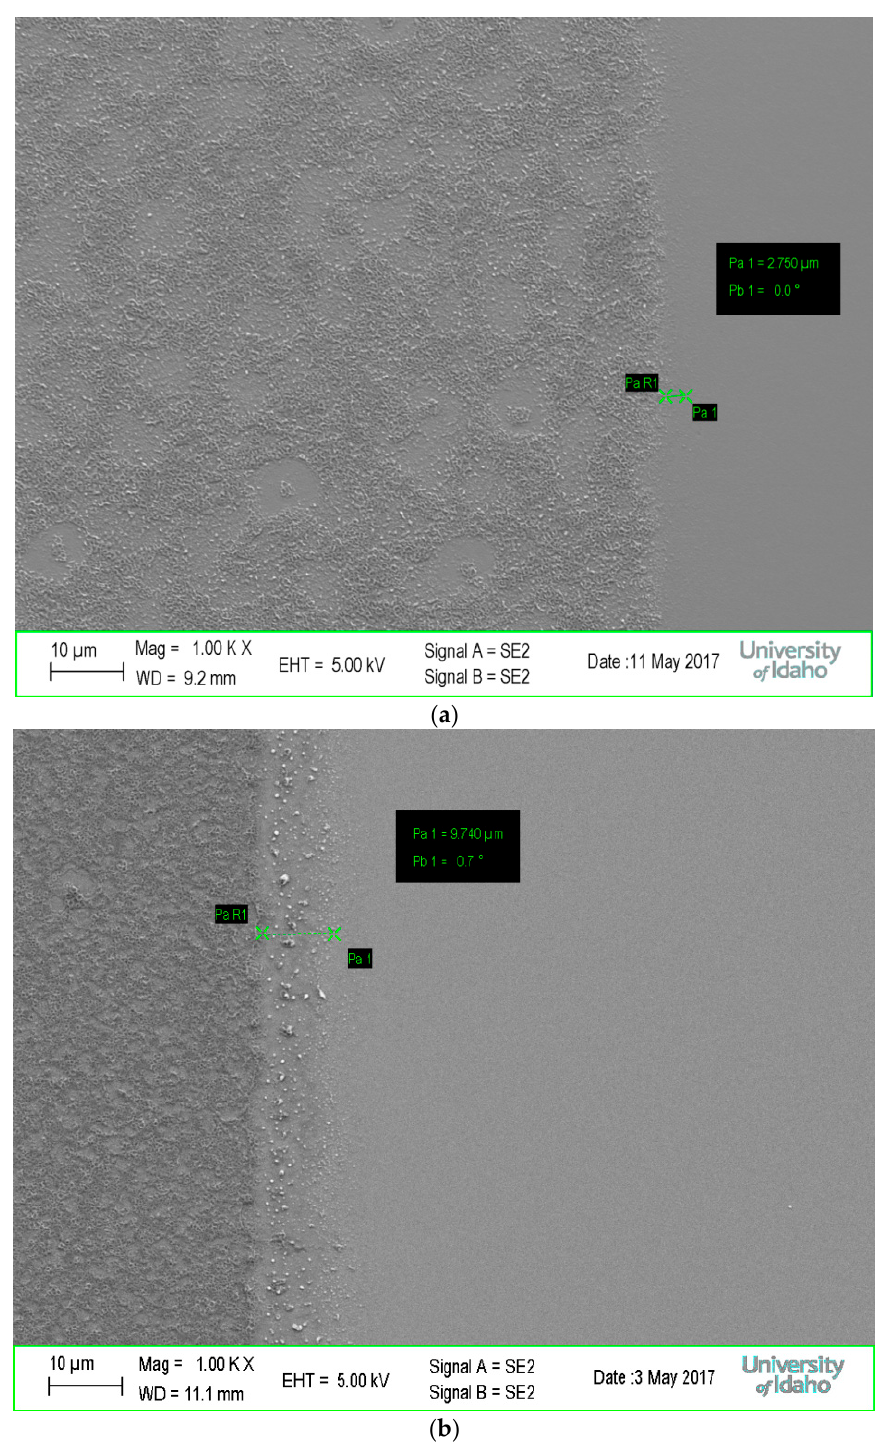
Figure 6. SEM imaging of ( a ) 50:50 NHNT and ( b ) 25:75 TPSTF examining line-edge roughness (LER) UV exposures.